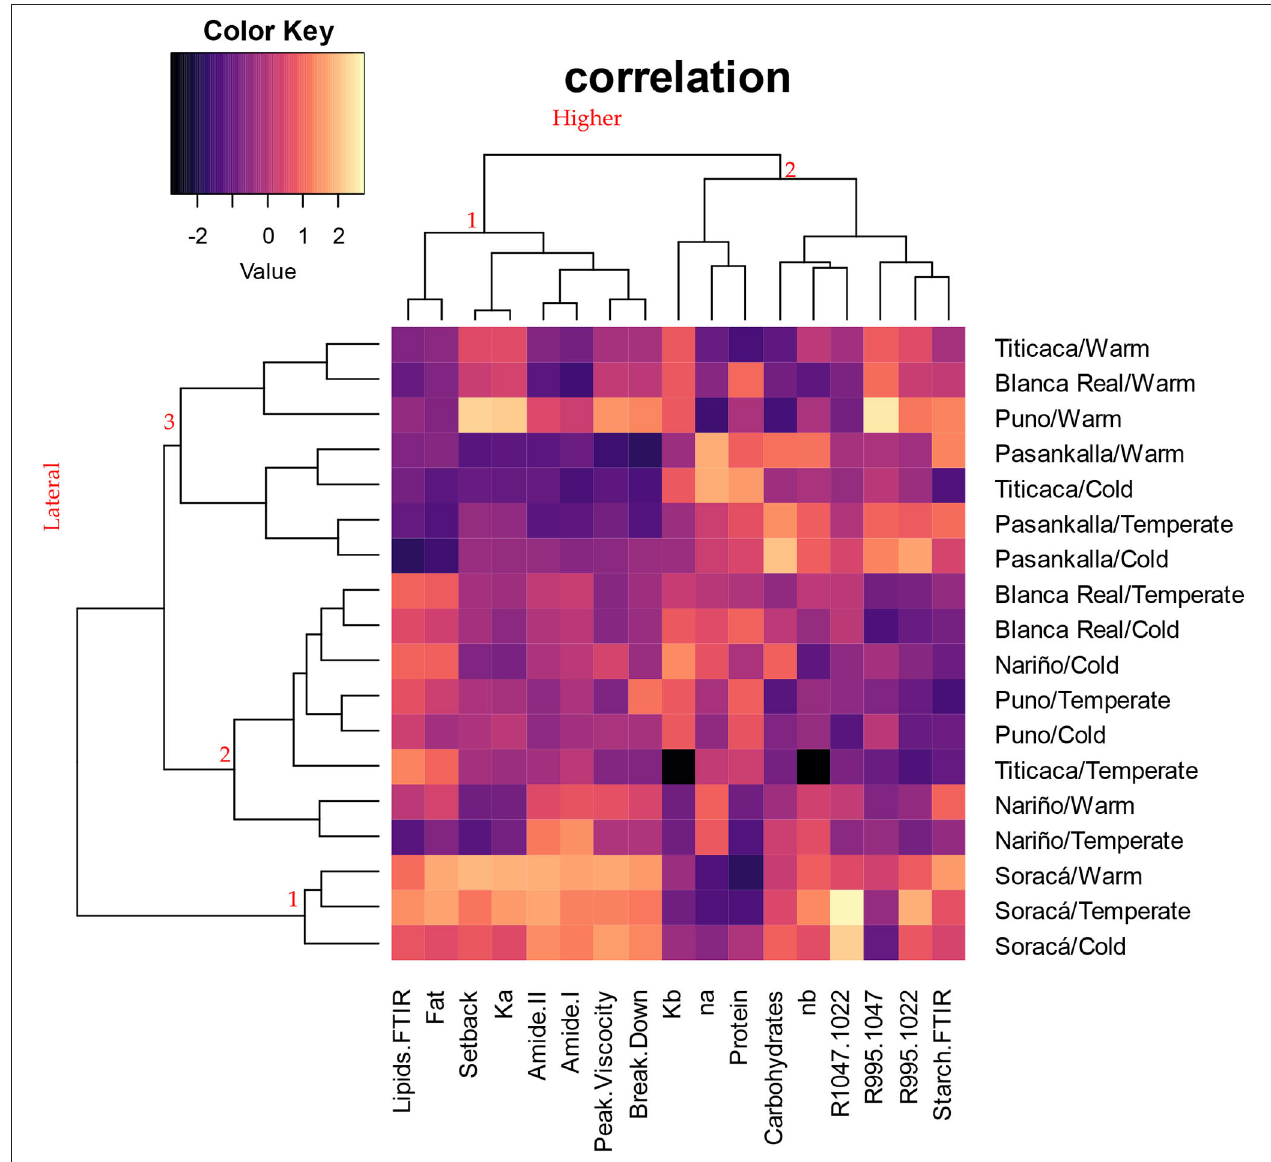
FIGURE 3 | Bootstrap-based clustering analysis with Manhattan distance from different structural and rheological variables for the evaluated